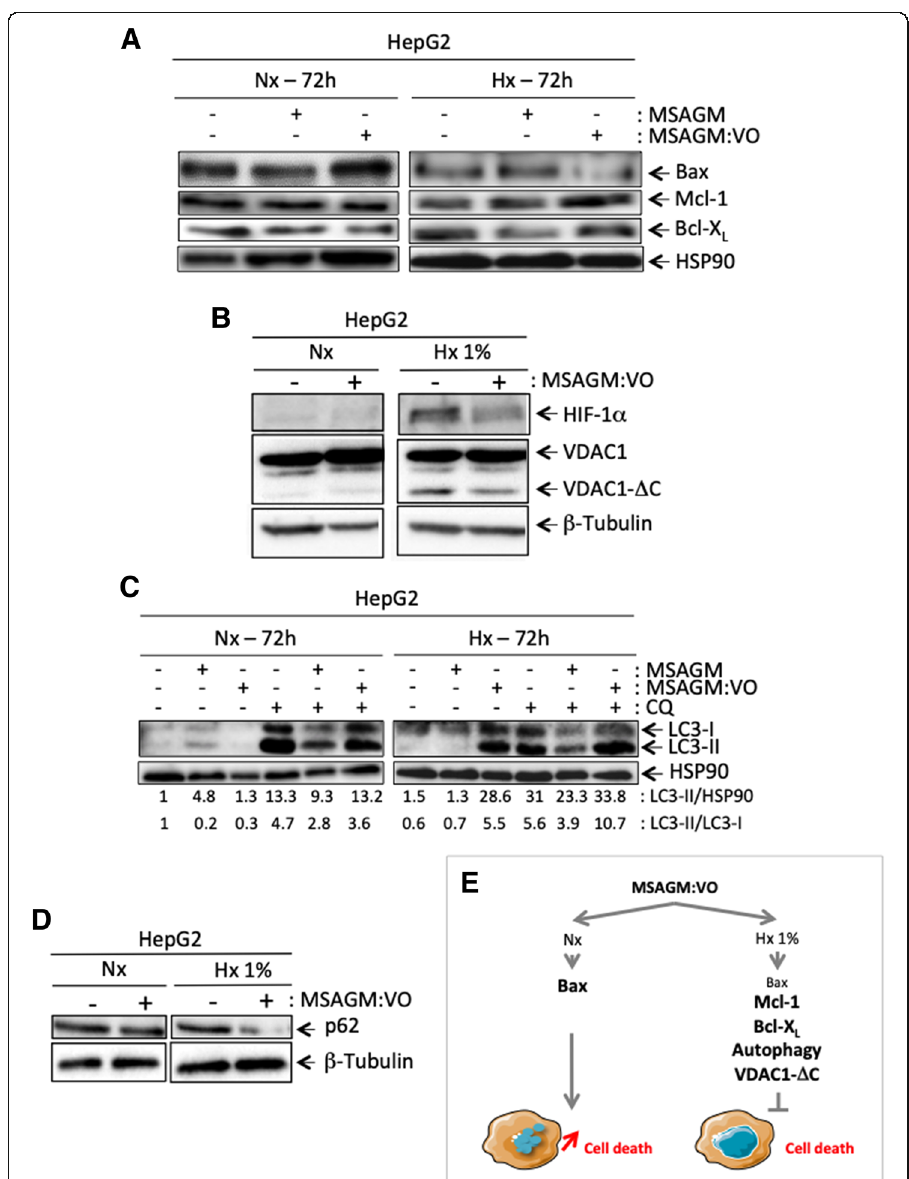
Fig. 2 Mechanisms activated in hypoxia protect cells from the apoptosis triggered by MSAGM:VO. a and b HepG2 were incubated in Nx or Hx 1% for 72 h in the absence ( − ) or presence (+) of MSAGM or MSAGM:VO. Cell lysates were analyzed by immunoblotting for ( a ) Bax, Mcl-1 and Bcl-X L and ( b ) HIF-1 α and VDAC1. HSP90 and β -tubulin were used as a loading control. c HepG2 cells were incubated in Nx or Hx (1% O 2 ) for 72 h in the absence ( − ) or presence (+) of MSAGM or MSAGM:VO and in the absence ( − ) or presence (+) of chloroquine (CQ). Cell lysates were analyzed via immunoblotting for LC3-I and -II. HSP90 was used as a loading control. d HepG2 cells were incubated in Nx or Hx 1% for 72 h in the absence ( − ) or presence (+) of MSAGM:VO. Cell lysates were analyzed via immunoblotting for p62. β -tubulin was used as a loading control. e Schematic representation of a pathway for hypoxic protection of HepG2 cells in the presence of